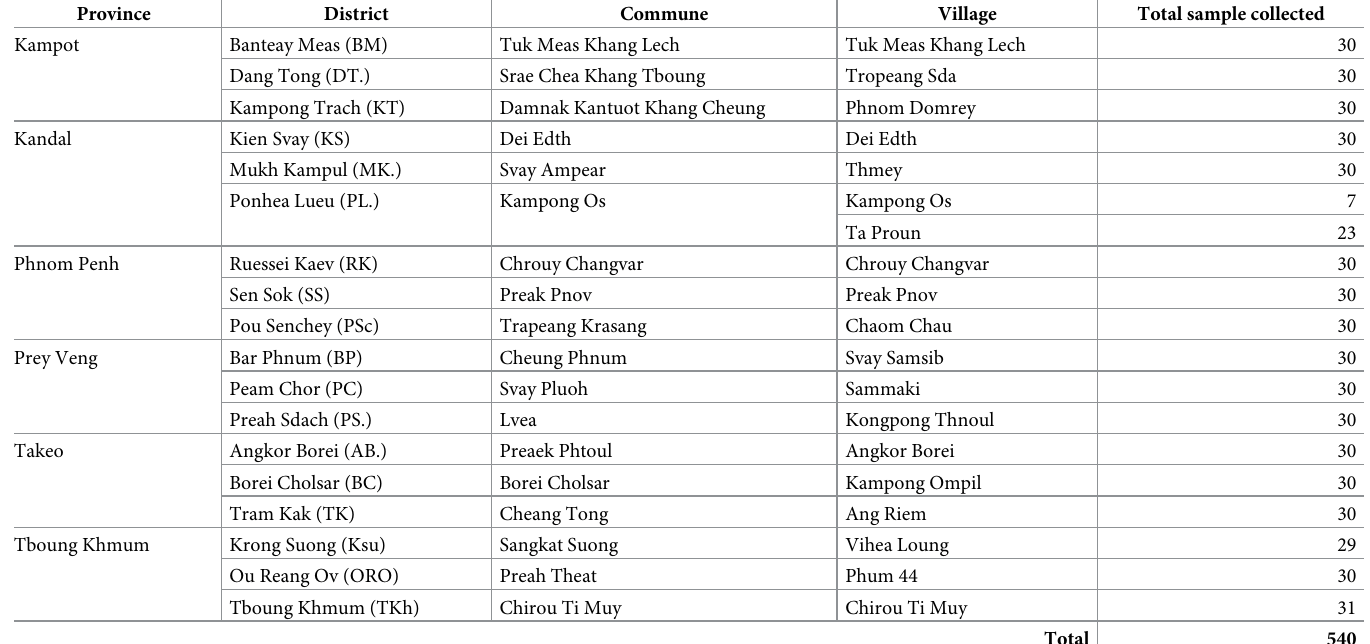
Table 1. The sample size of each selected village.